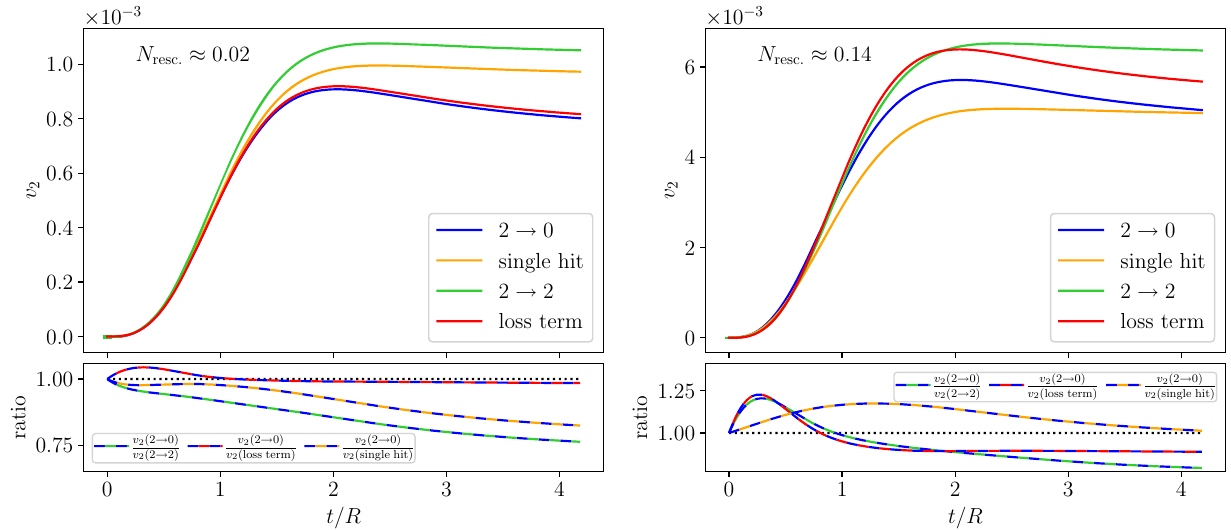
0 . 4 t/R Fig. 3 Top: Time dependence of elliptic flow v 2 in systems with ini- curves for the single-hit model, and the red ones show the analytical tially ε 2 = 0 . 15 and on average N resc . ≈ 0 . 02 (left) or 0 . 14 (right) result (14). The bottom panels show ratios of the curves from the upper rescatterings per particle. The green curves are for systems with elastic binary scatterings, the blue lines for the 2 → 0 scenario, the orange